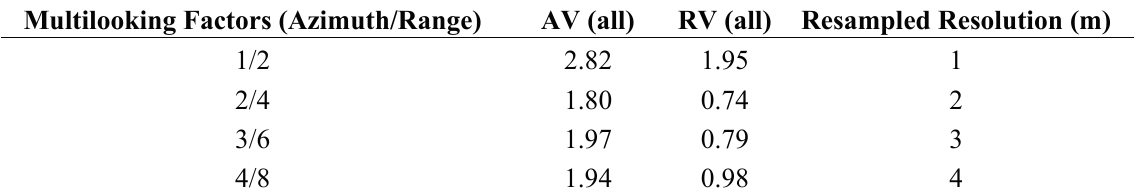
Table 3. Mean absolute vertical accuracy ( AV in m) and relative vertical accuracy ( RV in m) of TanDEM-X HS DEM (ALT-2) compared to RTK-GPS field survey for different multilooking